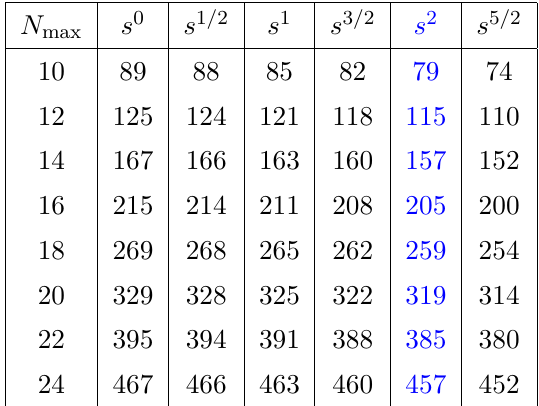
Table 1 . Number of parameters in our ansatz as we fix the proper low energy behavior to higher and higher orders in small s . The column s a corresponds to setting to zero all terms in (2.4) that greater or equal than s a in the small s expansion. The plots in this paper are obtained for the next to the last column, in